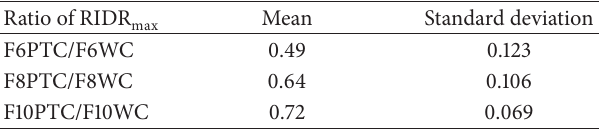
Table 3: Mean and standard deviation of RRD values. Ratio of RIDR Mean Standard deviation max F6PTC/F6WC 0.49 0.123 F8PTC/F8WC 0.64 0.106 F10PTC/F10WC 0.72